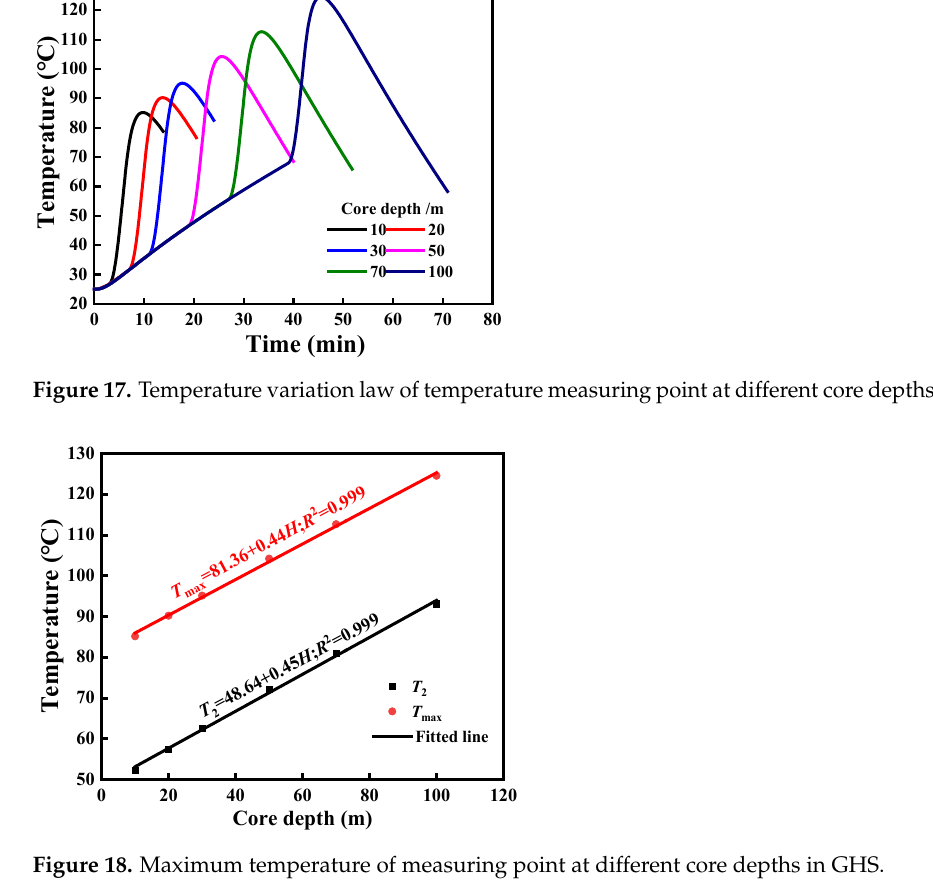
Figure 18. Maximum temperature of measuring point at different core depths in GHS.